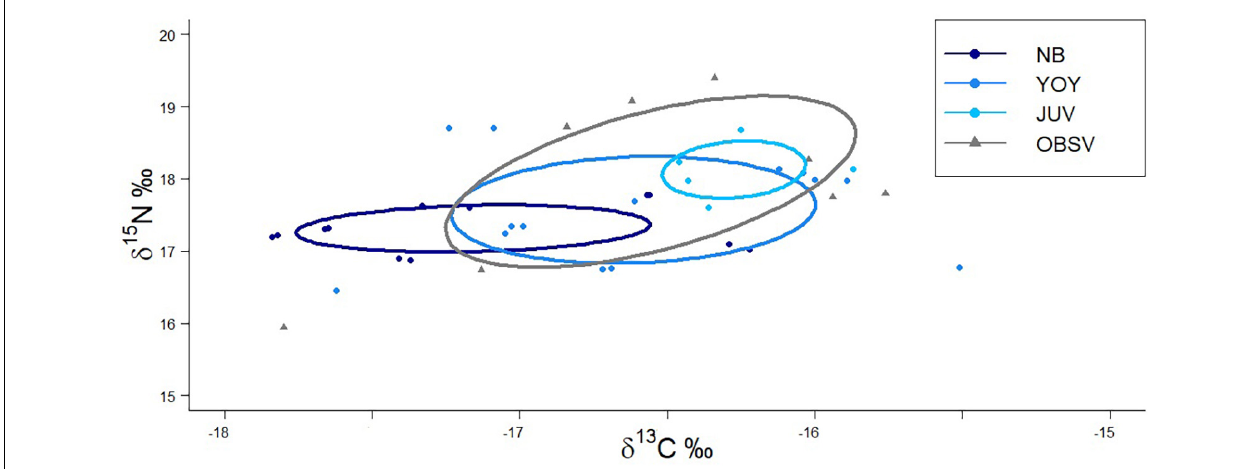
FIGURE 4 | Standardized ellipse of isotopic niches of immature white sharks sampled along the western coast of the Baja California peninsula. NB, newborn; YOY, young of the year; JUV, juvenile collected within Bahía Sebastián Vizcaíno; OBSV, juveniles outside Bahía Sebastián Vizcaíno. Points indicate individual values from immature white sharks